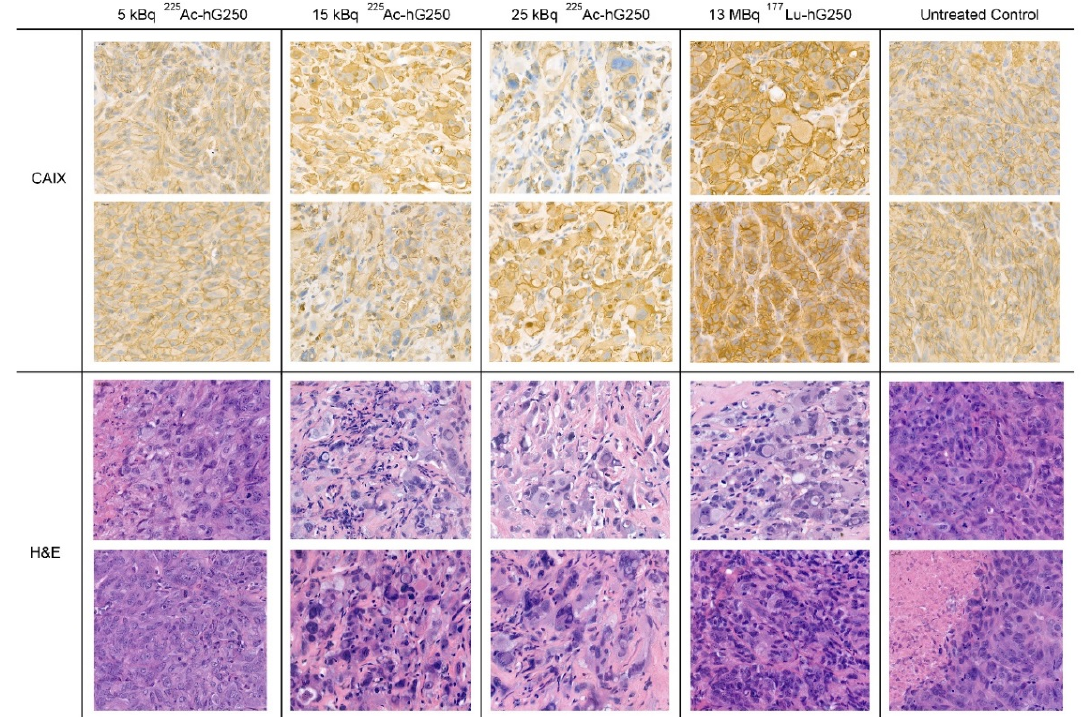
Figure 4. Representative SK-RC-52 tumor slices 125–150 days post-inoculation from mice treated with 225 Ac-hG250, 177 Lu-hG250, or untreated control. Upper panel: carbonic anhydrase IX staining, demonstrating a remaining transmembranous CAIX expression after treatment. Lower panel: hematoxylin and eosin staining, displaying radiation damage (enlarged nuclei, atypical nuclei, and intercellular fibrosis) in mice treated with 15, 25 kBq 225 Ac-hG250 or 13 MBq 177